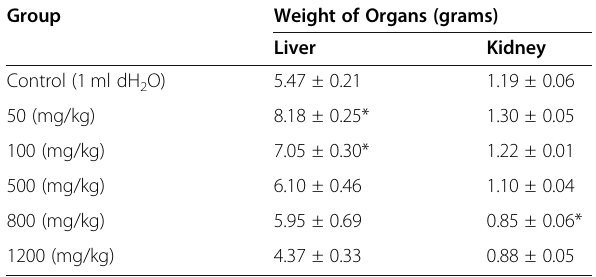
Table 2 Effects of J. carnea leaf ethanol extract on the weight of liver and